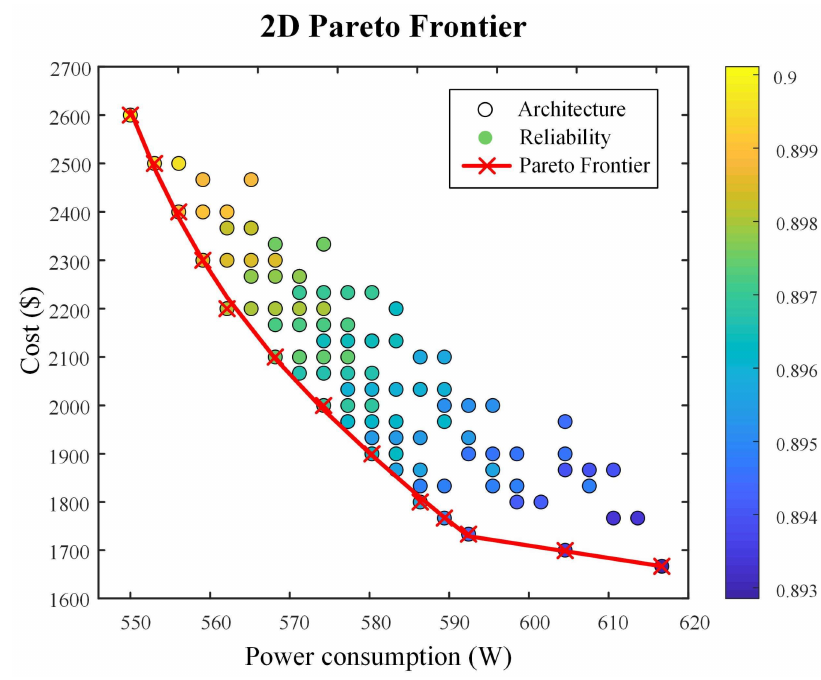
Figure 14. 2D Pareto frontier among power consumption, cost, and